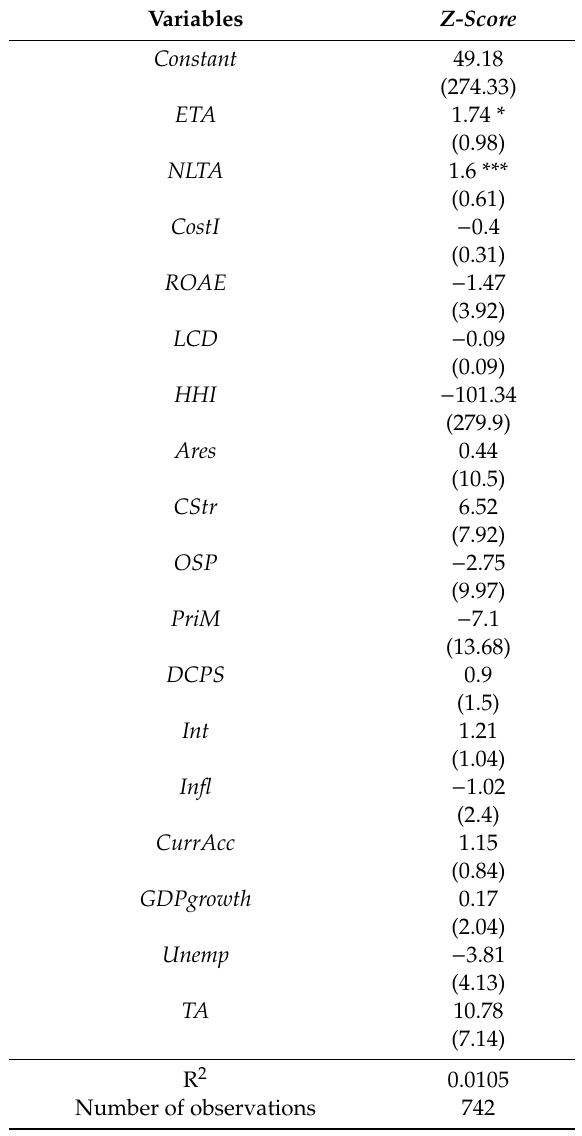
Table 4. OLS for Z-score